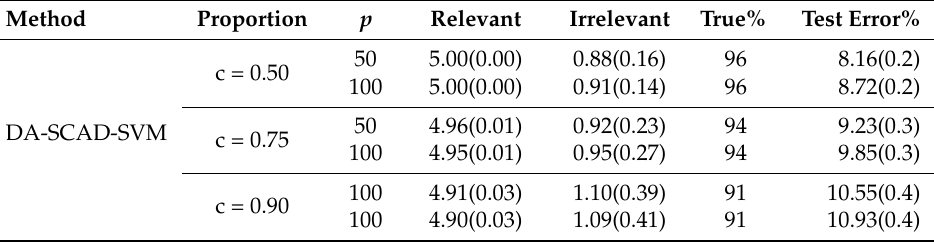
Table 1. Simulation study outcome where the sample size n = 100. Margins are provided in